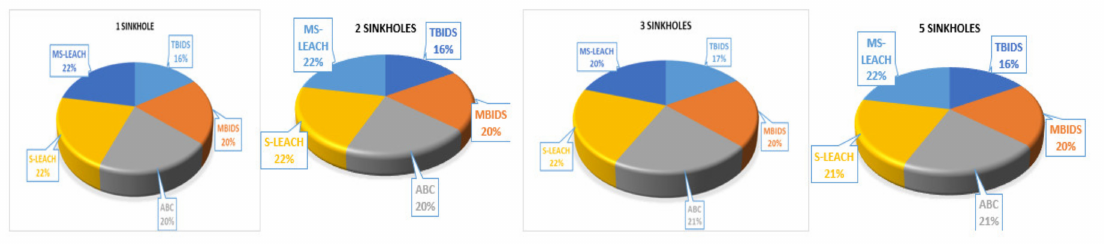
Figure 13. Energy consumption for a large-scale network with 1, 2, 3, and 5 sinkholes.